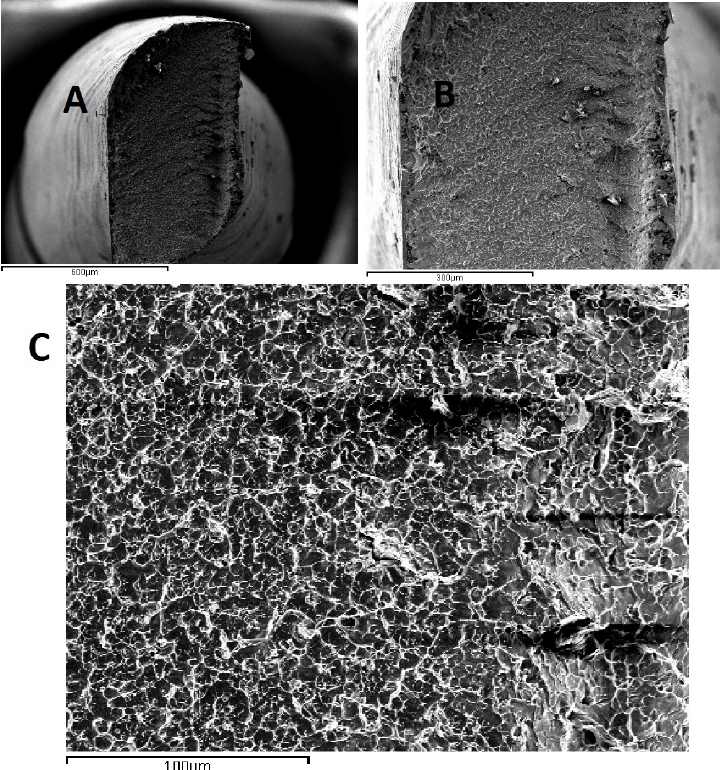
Figure 5. SEM photographs of the fracture site and type of fracture in Reciproc file. Crack at 45° and ductile fracture (( A ): 100×; ( B ): 200×: ( C ): 500×).